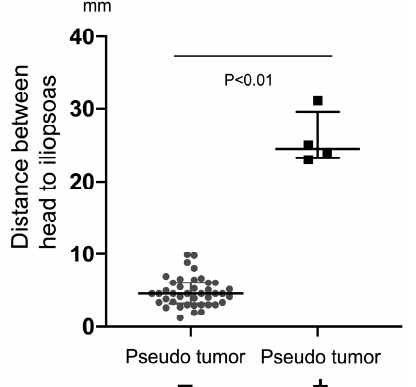
Figure 4. Comparison of the anterior distance between pseudotumor and non-tumor patients. The distances between the resurfacing head and the iliopsoas in the anterior part were measured in all HRA patients by ultrasonography. The median distance was significantly higher in the pseudotumor patients (4.5 mm vs. 24.5 mm, p < 0.01, Mann–Whitney test). Bar denotes median and interquartile range.